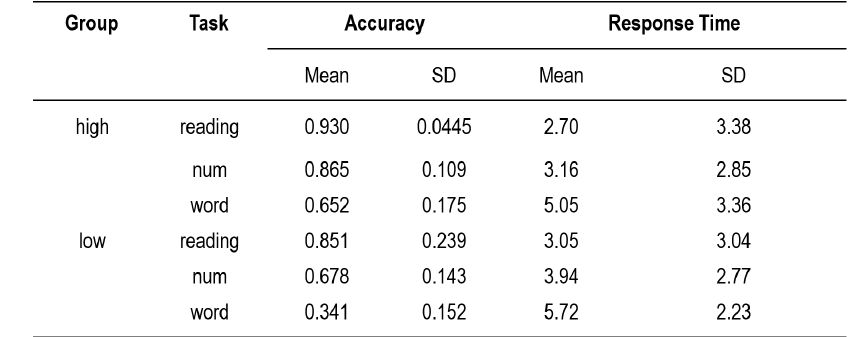
Mean scores and mean response time within three experimental conditions in groups of high-level and low-level performers